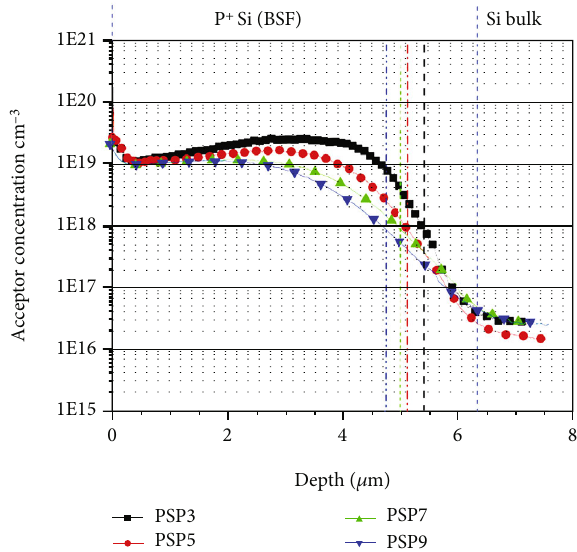
Figure 6: ECV curve of four kinds of Al paste.